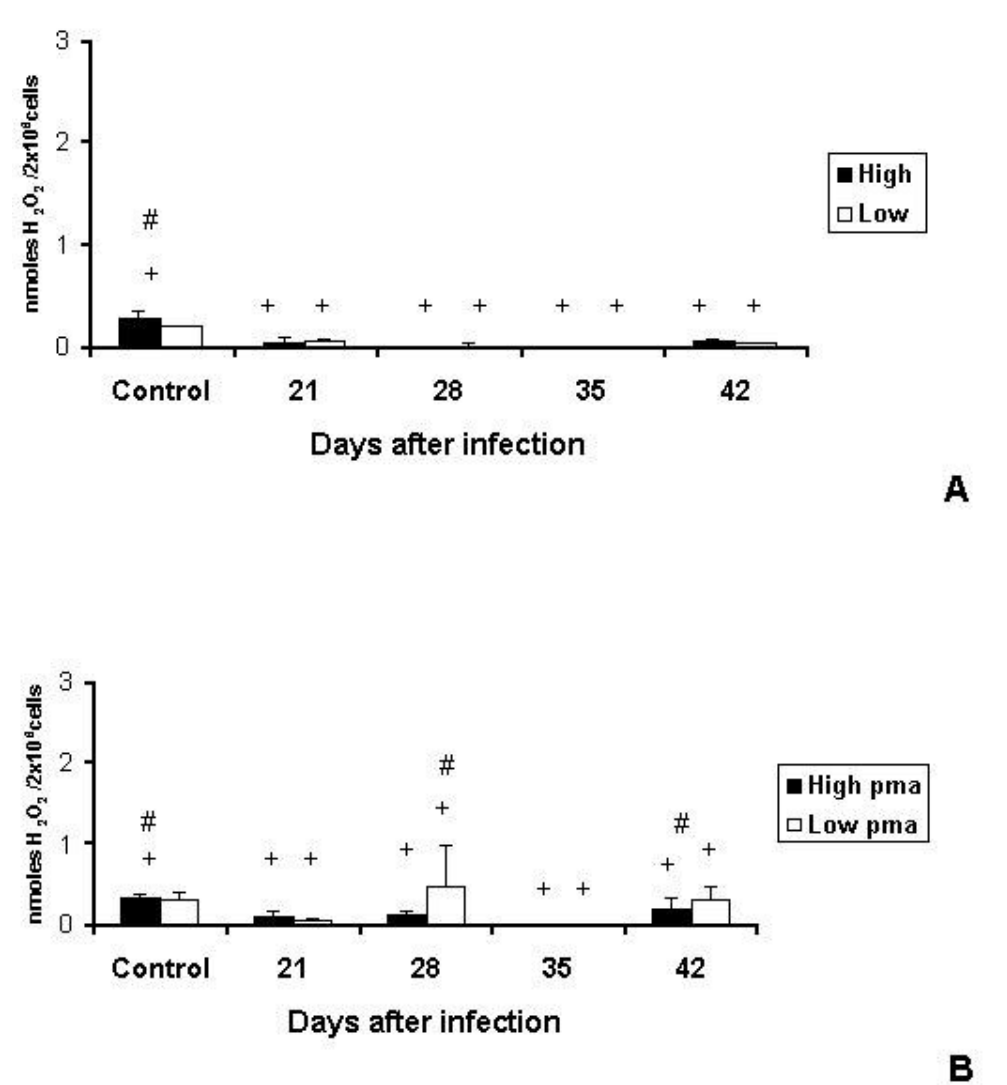
Figure 4. Production of H O (nmoles H O /2X10 6 cells) by splenic macrophages of 2 2 2 2 High and Low antibody producer (Selection IV-A) mice infected with Mycobacterium bovis -AN at different periods, compared with their respective controls. 5 (A) Endogenous production of H O by macrophages of infected High and Low mice. 2 2 (B) Endogenous production of H O by macrophages of infected High and Low mice 2 2 subjected to additional phorbol myristate acetate (pma) stimulus. #: interline difference +: difference between infected animals and their respective